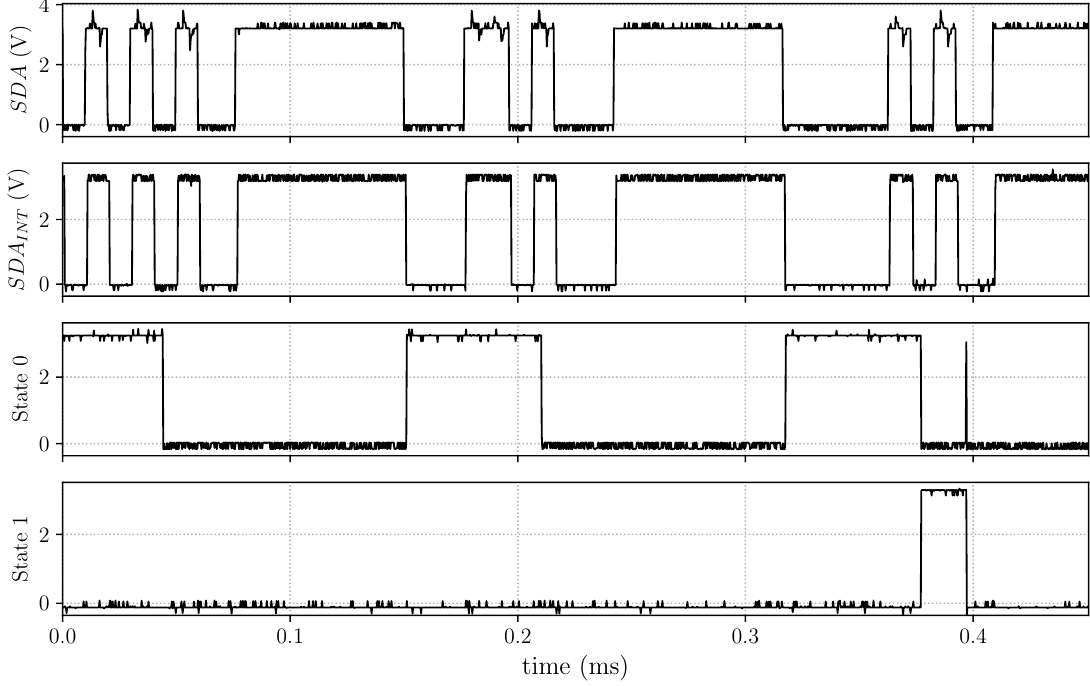
Figure 10. Measurement of the external and internal communication signals (SDA only) and the resulting effect on the switch’s state